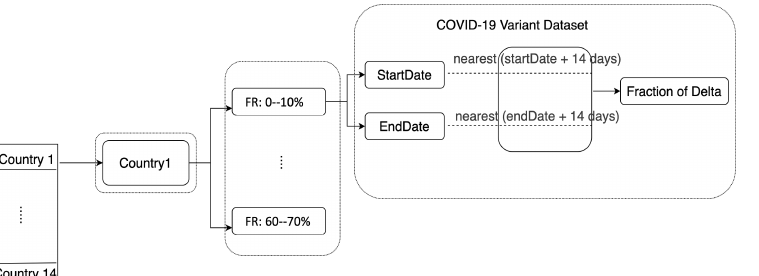
Figure 5. Flowchart showing the calculation of the fraction of Delta variant for each fraction of resistance period across all of the 14